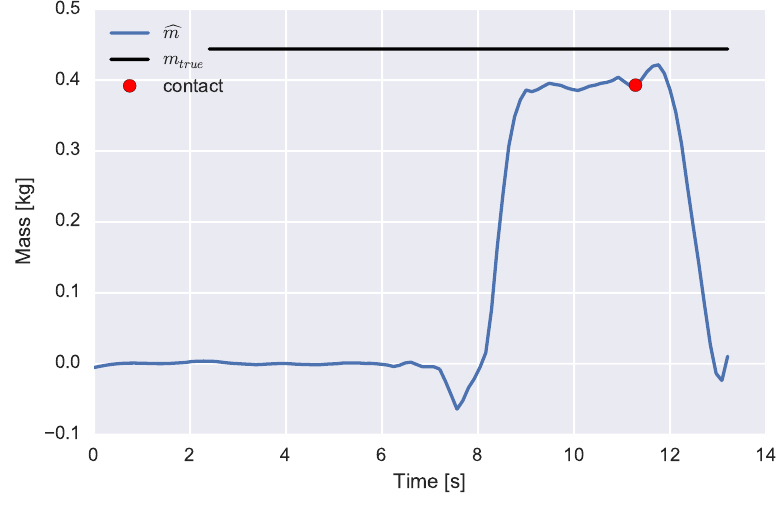
Figure 7. Experiment 1: lifting the cylindrical mass load (0.44 kg). The estimated (blue) and true (black) mass weight parameter value are displayed. The load has been grasped at approximately t = 7 s. A point estimate of the mass value used for further analysis is indicated by a red